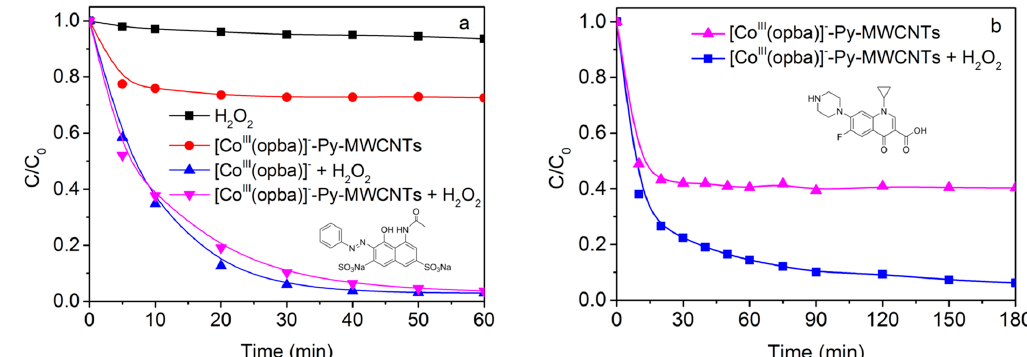
Figure 3. ( a ) Concentration changes of AR1 with 4.0 × 10 − 3 mol/L H 2 O 2 at 25 °C ([Co III (opba)] − -Py- MWCNTs = 0.2 g/L, the same mole amount of [Co III (opba)] − as [Co III (opba)] − -Py-MWCNTs, [Co III (opba)] − = 0.02 mM, pH 9.0 (0.01 mol/L borate buffer)); and ( b ) CIP with 1.0 × 10 − 2 mol/L H 2 O 2 at 45 °C. ([Co III (opba)] − -Py-MWCNTs = 0.2 g/L, pH 8.2 (0.01 mol/L borate buffer)).